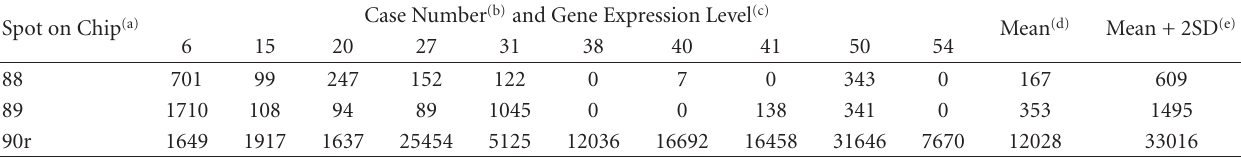
Figure 1. (b) Ten oral cancer specimens shown here are determined to be EBV-negative by the criteria described in the Materials and Methods Section, and the numbers correspond to the patient number shown in Table 1. (c) The gene expression levels were represented as the arbitrary numbers of hybridization signals (blue-spots on EBV-chips) digitalized by ScanAlyze program [32]. Owing to the highly sensitive tyramide-biotin signal amplification method, some spots on the EBV-chips hybridized to the cDNA samples from the EBV-negative tissues still revealed viral gene expression signals, which were considered as the background signals. (d) Mean values with their standard deviations (SDs) of the background gene expression levels for all spots were calculated. (e) The values of means plus two-time SD were obtained as the threshold expression levels for calculating the viral gene expression levels in EBV-positive